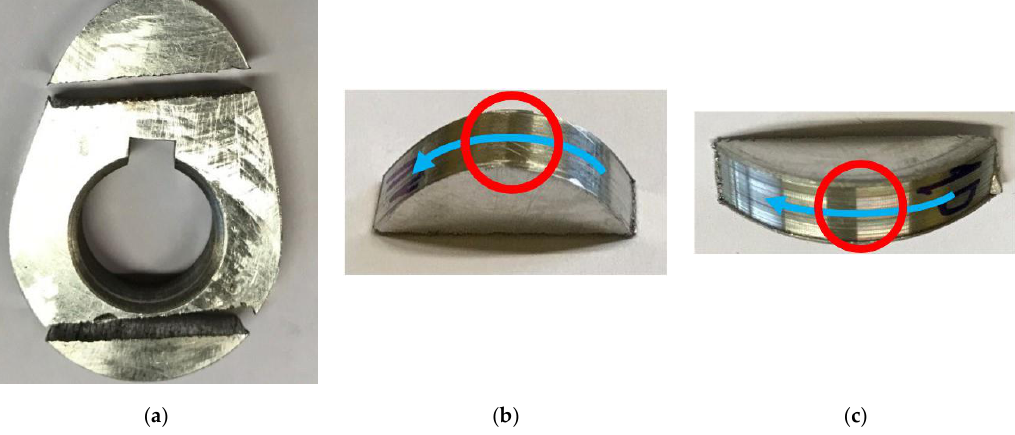
Figure 7. Study zones of the worn cam (highlighted with red circles), where the blue arrows show the direction of the grooves: ( a ) cam cut into three parts; ( b ) upper zone; ( c ) lower zone. Figure 8 shows SEM micrographs for the AA5083-N0-T200 cam worn after 200 × 10 3 rev at two different magnifications of 200× and 1000×, where the direction of the grooves was parallel to the cam profile plane and was contained in the cam contact surface (see blue arrows in Figure 7).